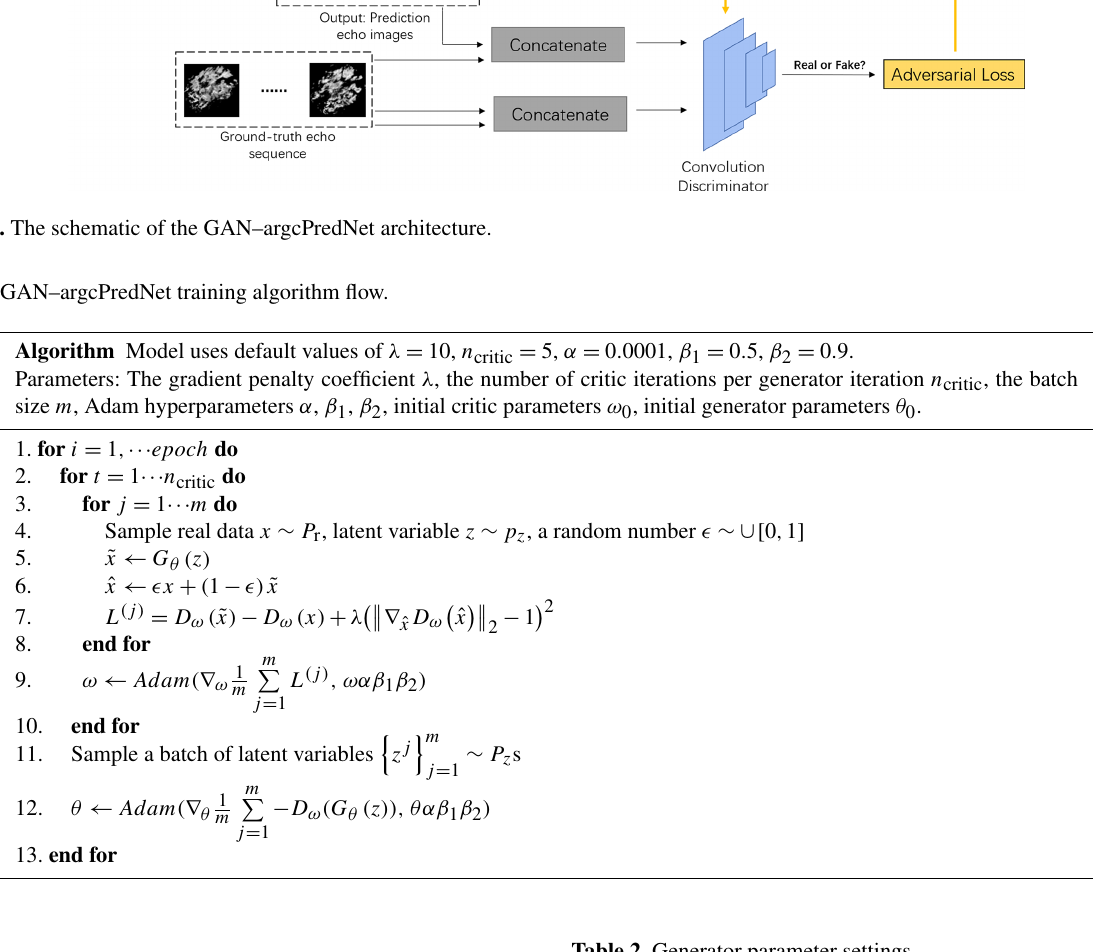
Table 2. Generator parameter